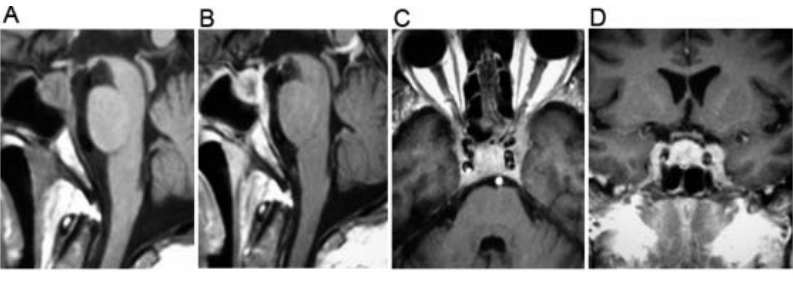
Figure 1. A cranial magnetic resonance imaging showed an intrasellar mass. (A) A sagit- tal T1-weighted image revealed a sellar lesion with hypointense areas. (B) A gadolinium- enhanced sagittal image showed an enhancing lesion with a hypointense center. Axial (C) and coronal (D) images demonstrated parasellar extension toward the left cavernous